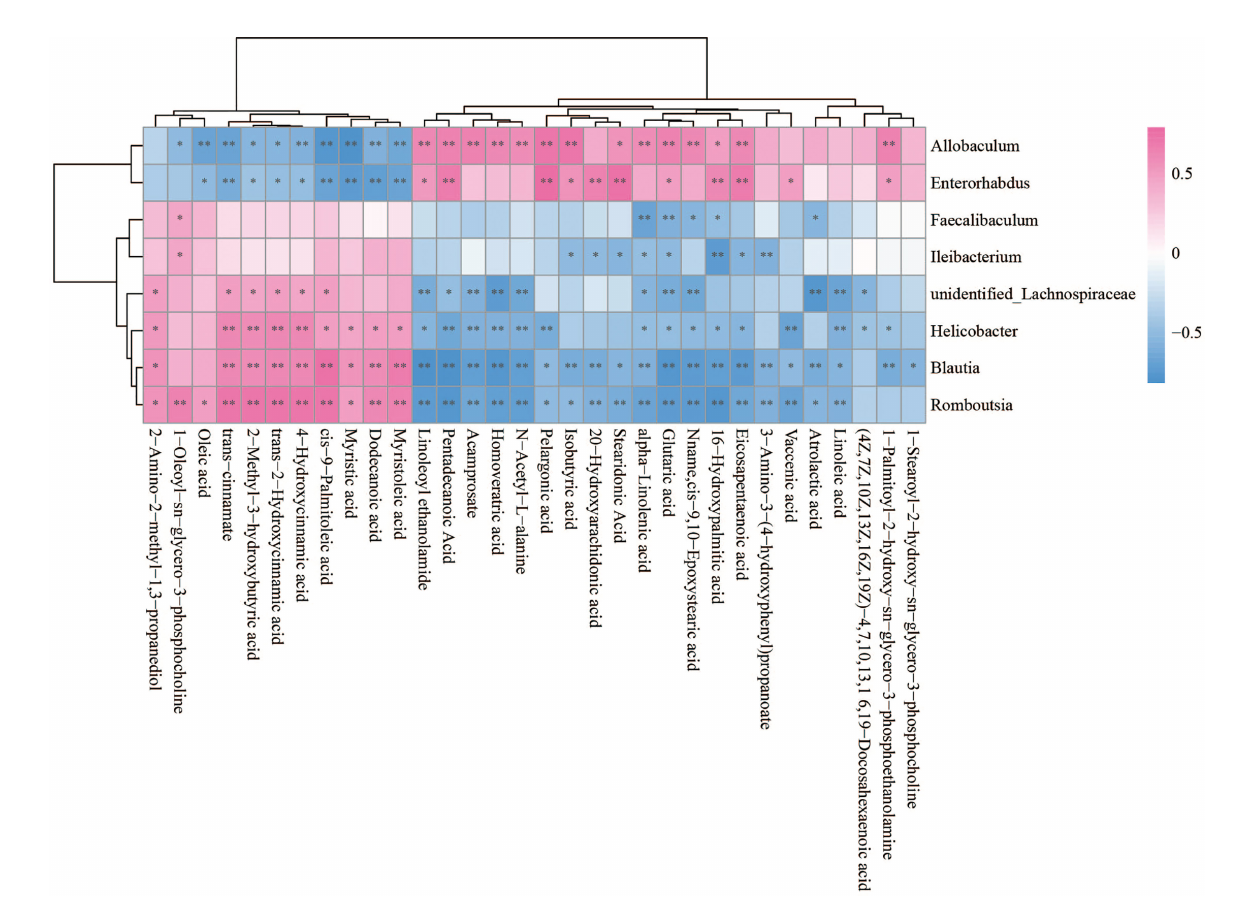
FIGURE 7 | Spearman correlations between signi fi cant bacteria based on LEfSe and differential lipid are presented in the form of a correlation coef fi cient matrix heat map. The correlation coef fi cient r is shown in color. r >0, positive correlation, shown in red; r < 0 represents a negative correlation, shown in blue, and the darker the color, the stronger the correlation. “ * ” indicated p-value < 0.05, “ ** ” indicated p-value <